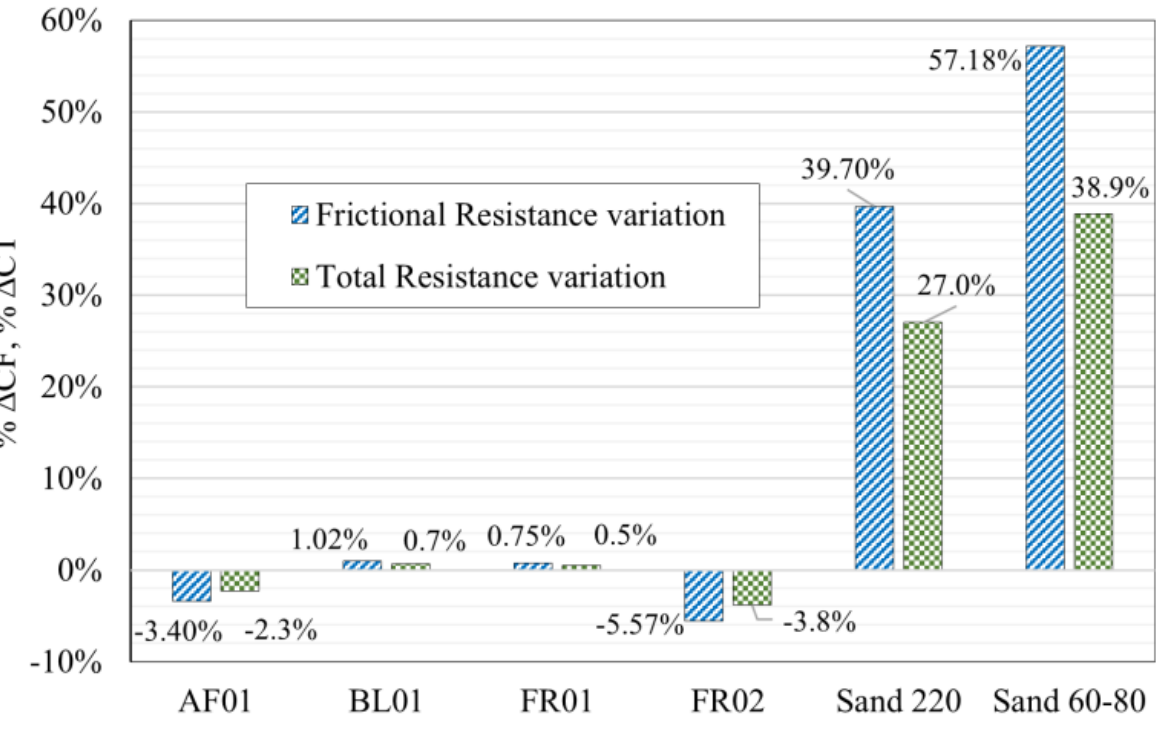
Figure 13. Percentage bar diagram of the resistance coefficients in different hull roughness condi- tions.